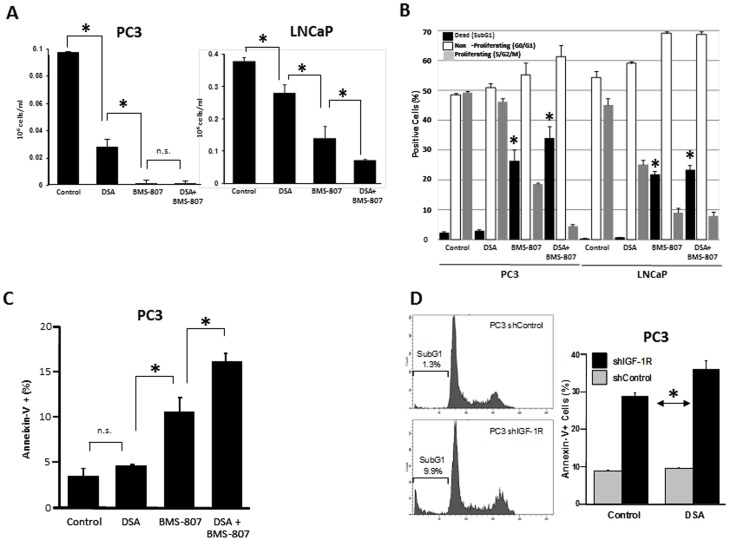
Dual inhibition of IR/IGF-1R and SFK decreases tumor growth in vitro more effectively than single pathway inhibition does.(A) PC-3 or LNCaP cells were cultured for 96 hours with and without dasatinib (DSA; 100 nM) and BMS-754807 (BMS-807; 2 µM for PC-3 and 0.5 µM for LNCaP cells), alone and in combination, and cell numbers were determined as described in the methods. (B) PC-3 and LNCaP cells were incubated for 24 hours with and without DSA (100 nM) and BMS-754807 (5 µM for PC-3 and 1 µM for LNCaP cells), alone and in combination, and cell cycle staining after 24 hours was performed using propidium iodide. (C) PC-3 cells were incubated for 48 hours with and without DSA (100 nM) and BMS-754807 (2 µM), alone and in combination, and the percentage of apoptotic cells was determined by flow cytometric analysis of annexin-V staining. (D)Left: cell cycle staining with propidium iodide in PC-3–shIGF-1R cells. Right: PC-3–shIGF-1R and control cells were incubated for 48 hours with and without DSA (100 nM), and the percentage of apoptotic cells was determined by flow cytometric analysis of annexin-V staining. All experiments were performed in triplicate. *P<0.05; N.S. not significant.